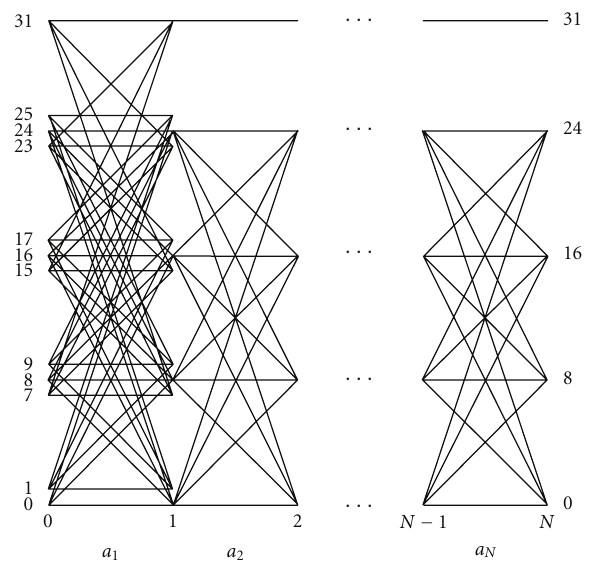
Figure 4: Trellis representation of the states z 0 , z 1 , ... , z N and the di ff erentially encoded symbols a 1 , a 2 , ... , a N in the incoherent case. An edge between two subsequent states indicates that a transition between these states is possible. Note that the trellis can be decomposed into eight unconnected